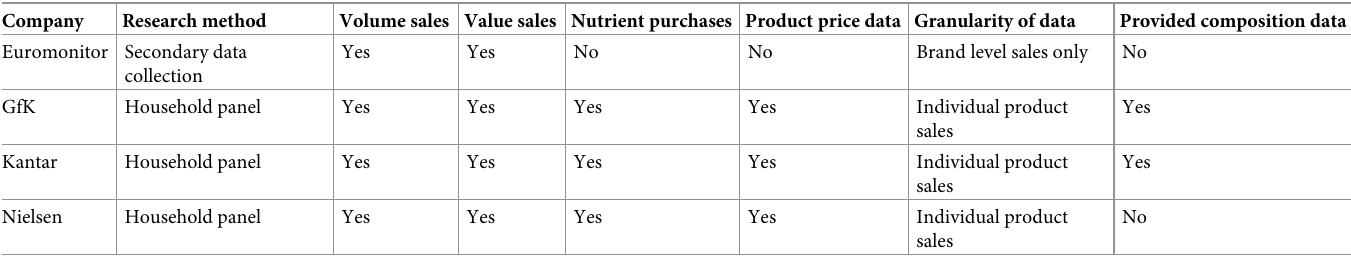
Table 2. Summary of data types used in the included studies by company.